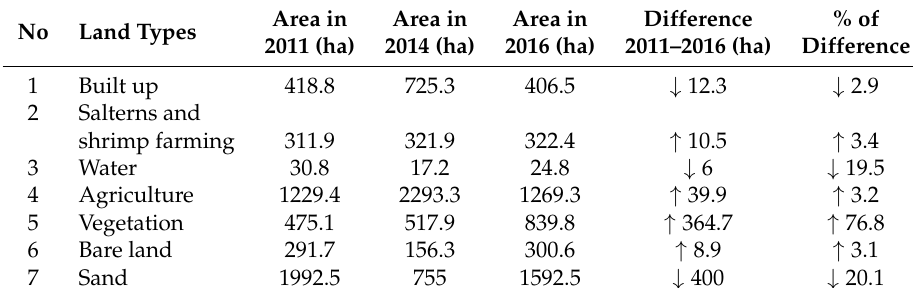
Table 4. Changes in different LULC types.